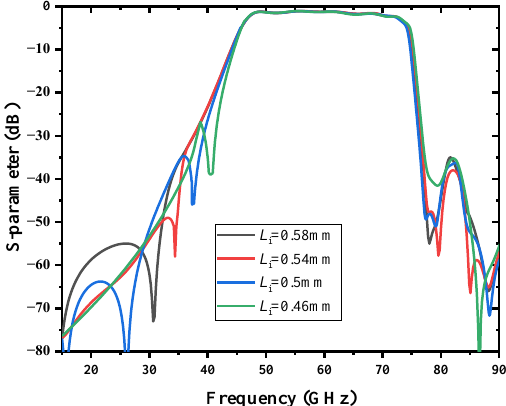
Figure 11. Simulated results with different interdigital capacitor length 𝐿 𝑖 .